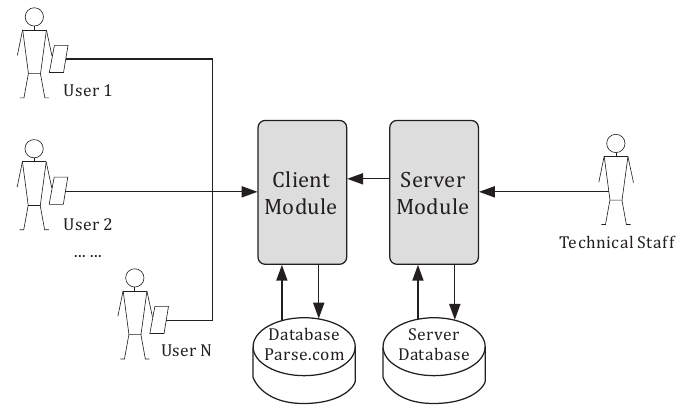
Figure 1. System